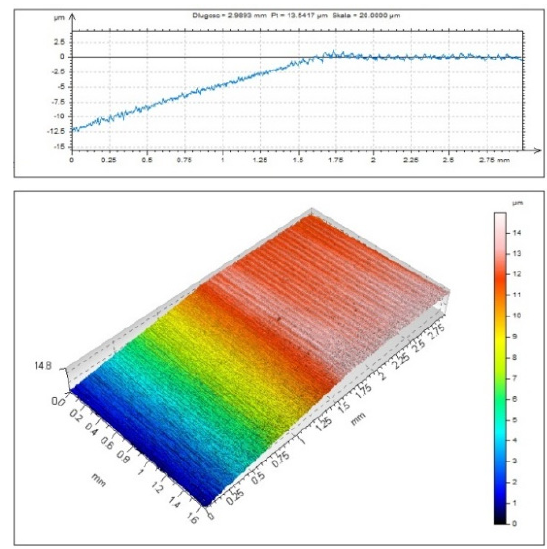
Figure 8. A 3D surface image and the corresponding 2D profile for a sample cut at v c = 360 m/min and f = 0.09 mm/rev using an insert with an edge radius of 49.9 µm.